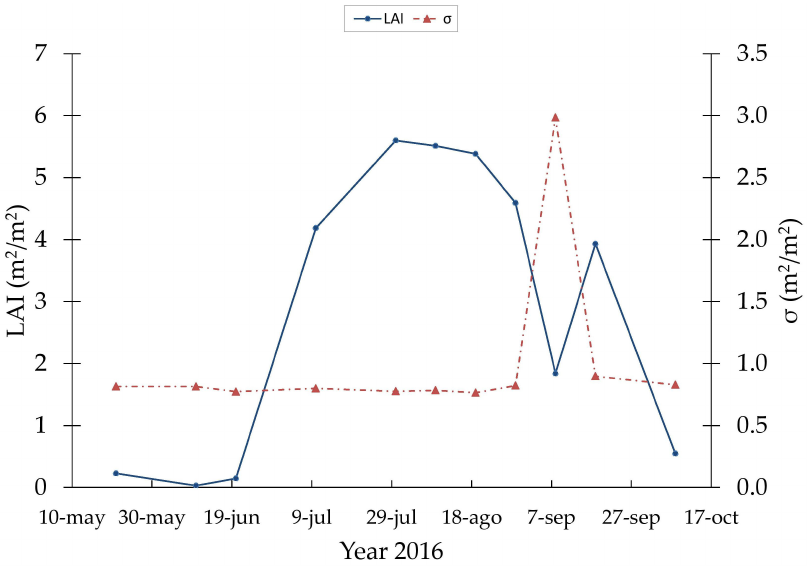
Figure 7. Temporal evolution of LAI and uncertainty ( σ ) over a rice field in Spain during the 2016 rice